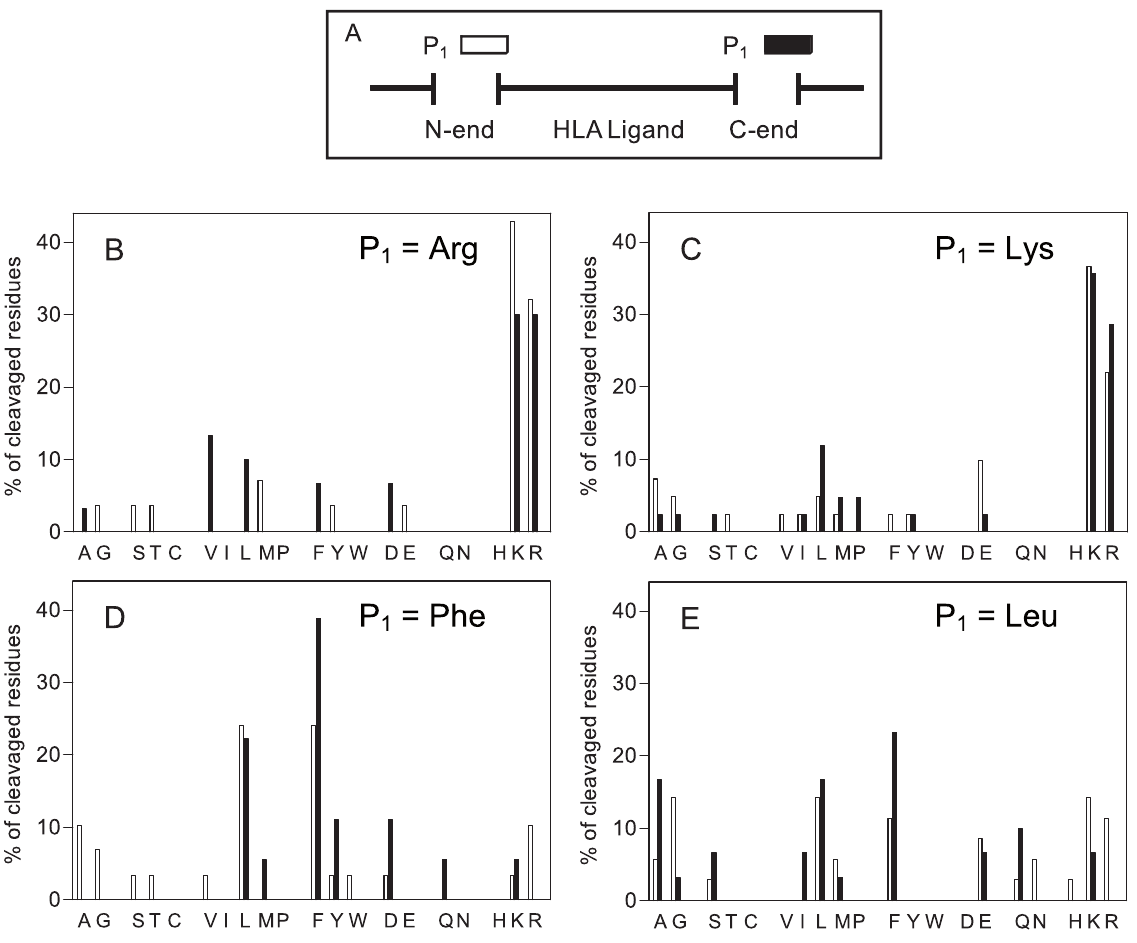
Figure 3. Analysis of the correspondence of P 1 N- and C-end cleavage specificity in HLA class I ligands. Panel A: A diagram of the residues involved in the generation of naturally processed HLA class I ligands by peptidase cleavage is shown. P 1 residue is indicated by white boxes (N-end) or black boxes (C-end). Panels B-E: A specific amino acid residue is indicated at the top right corner of each panel and the corresponding opposite residue identified in P 1 N-end (white boxes) or C-end (black boxes) is represented. For example, panel B indicates in white bars the residue located in the P 1 N-end position when Arg was identified in P 1 C-end, and in black bars the residue located in the P 1 C-end position when Arg was identified in the P 1 N-end position.